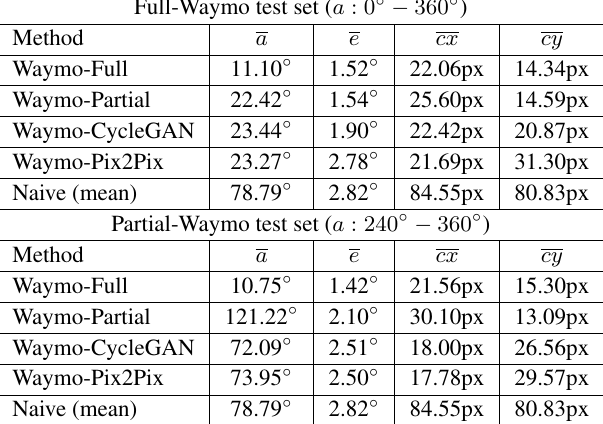
Table 1. Mean pose estimation accuracies of our deep convolutional neural network for the Full- and Partial-Waymo test